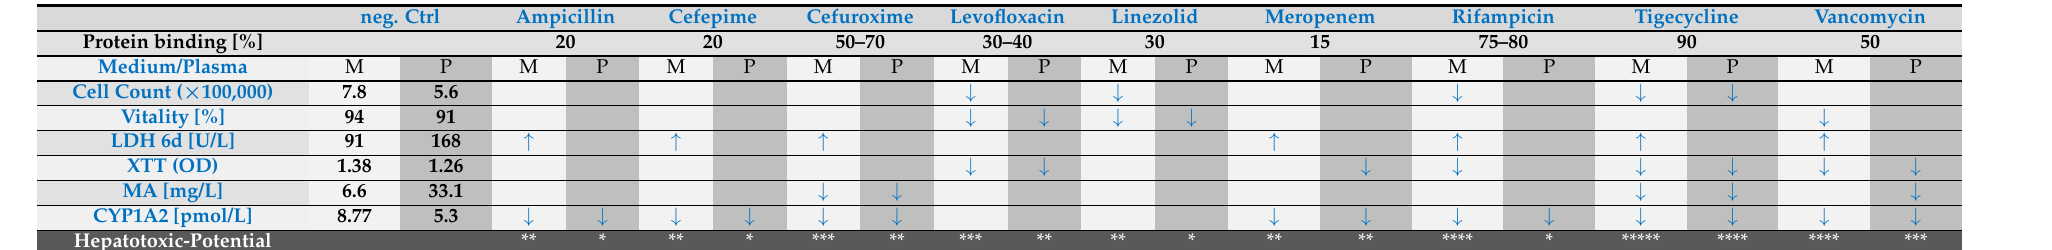
Table 2. Comparison of Cmax of the tested antibiotics in medium (M) and in plasma (P) compared to the negative control (neg. Ctrl.). The number of stars (significant difference relative to the negative control) represents the hepatotoxic potential of the tested antibiotics in medium and plasma at clinically relevant concentrations. MA: